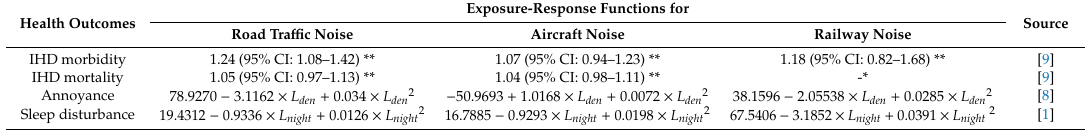
Table 2. Exposure-response functions for road, aircraft and railway